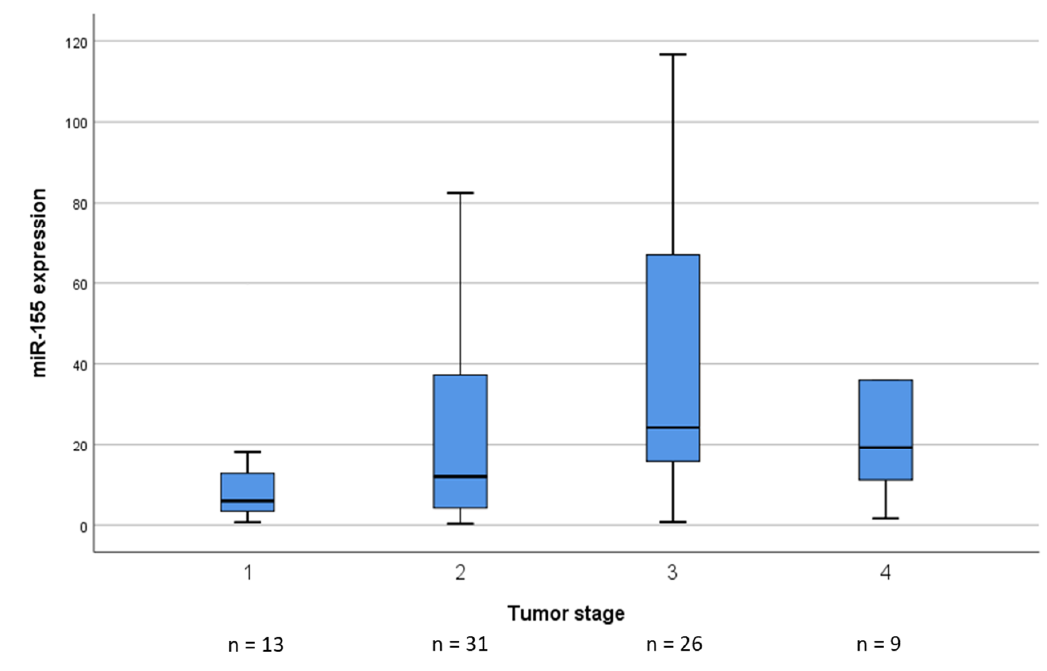
Figure 3. The distribution of miR-155 expression in relation to tumor stage. MiR-155 expression was significantly associated with tumor stage ( p = 0.01, Kruskal-Wallis test).